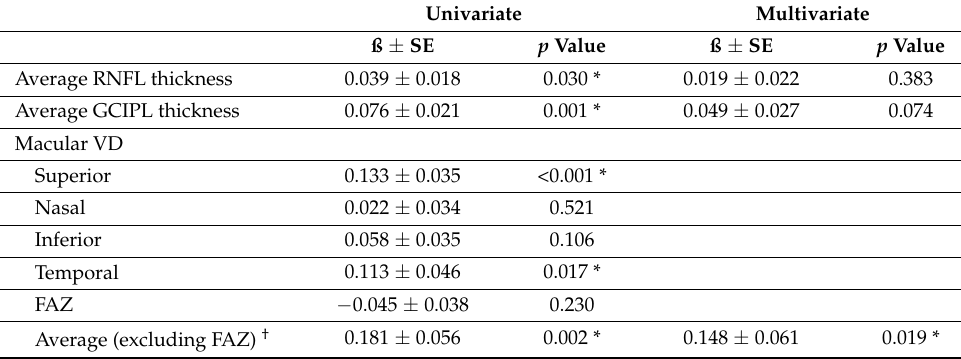
Table 5. Factors associated with the N95 amplitude in total subjects.